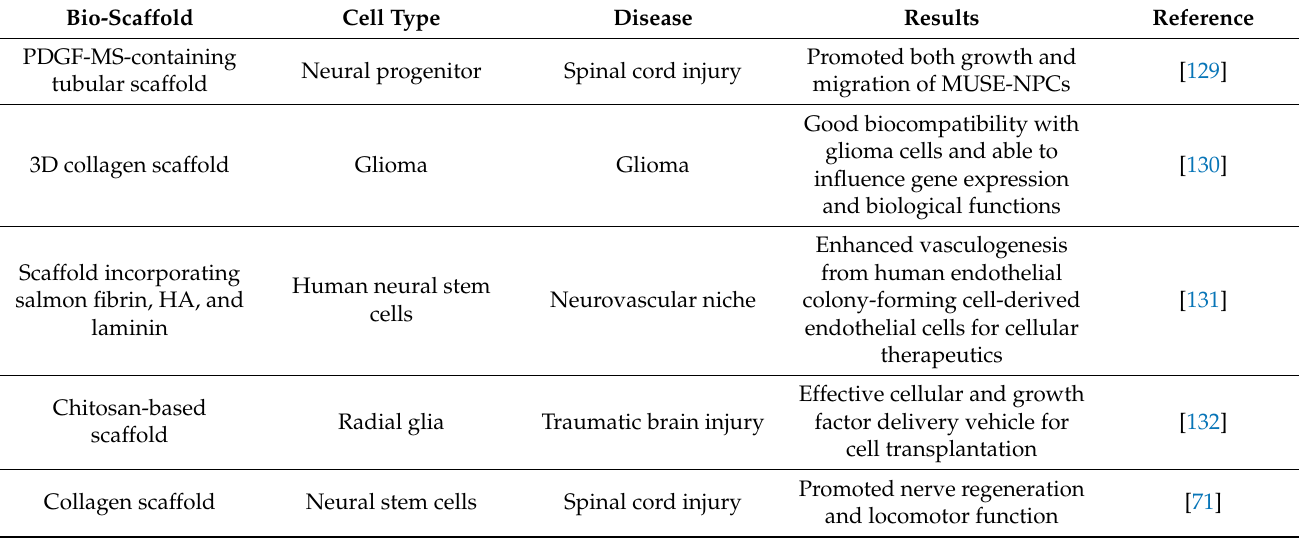
Table 2. Recent studies using bio-scaffolds for nerve injury repair in animal models. Bio-Scaffold